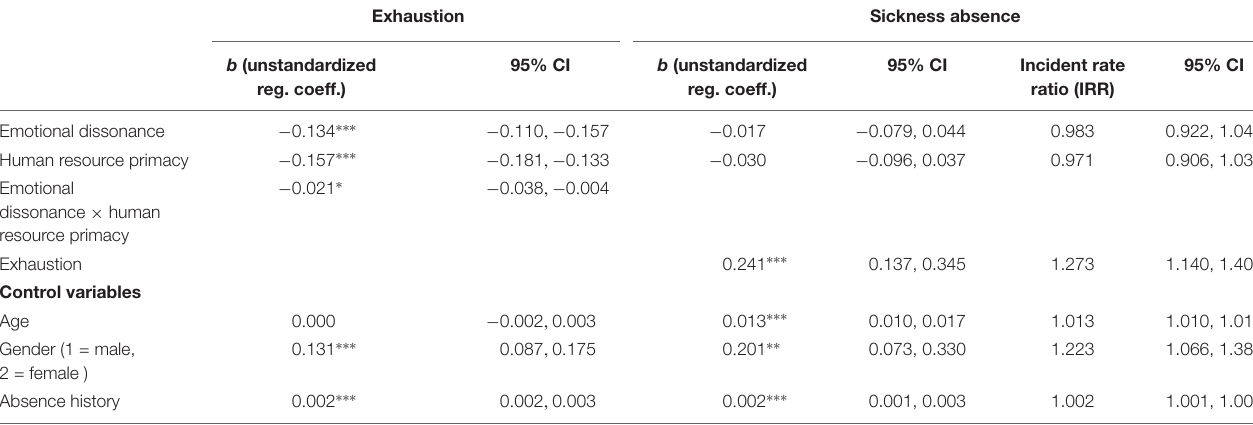
TABLE 3 | Regression coefficients and incidence rate ratio with confidence intervals for paths included in the full moderated mediation model. Exhaustion Sickness absence b (unstandardized 95% CI b (unstandardized reg. coeff.) reg. coeff.)